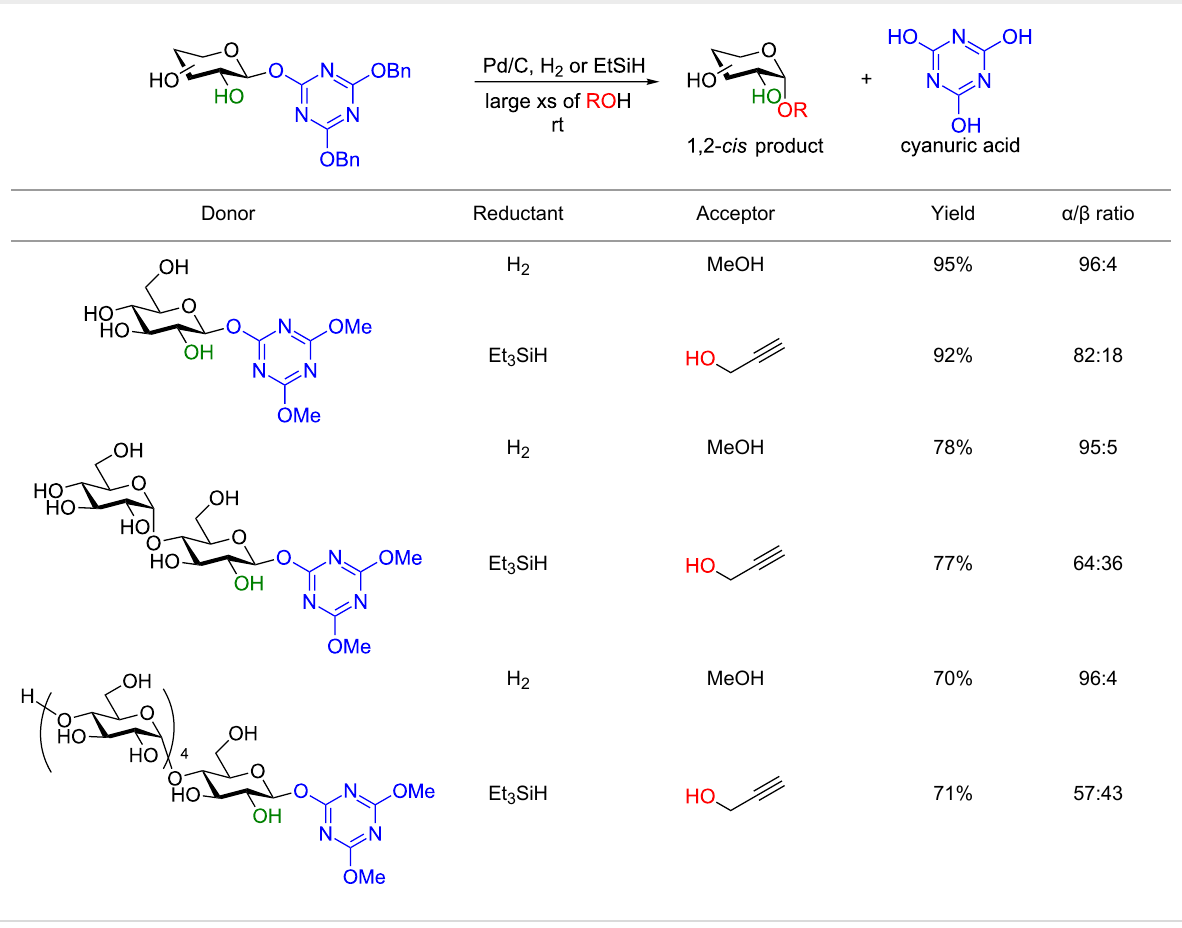
Table 7: Protecting group-free glycosylation by using DBT donors under hydrogenolytic